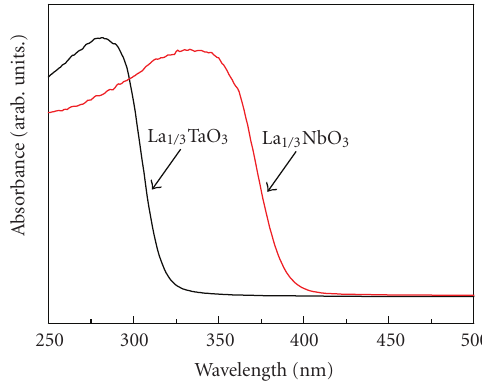
Figure 3: UV-Vis di ff use reflection spectra of La 1 / 3 MO 3 (M = Nb,